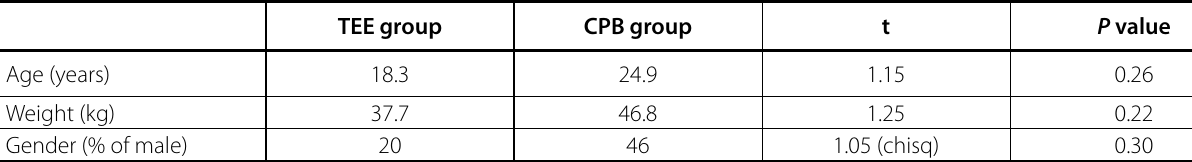
Table 1. Age, weight and gender in two groups.